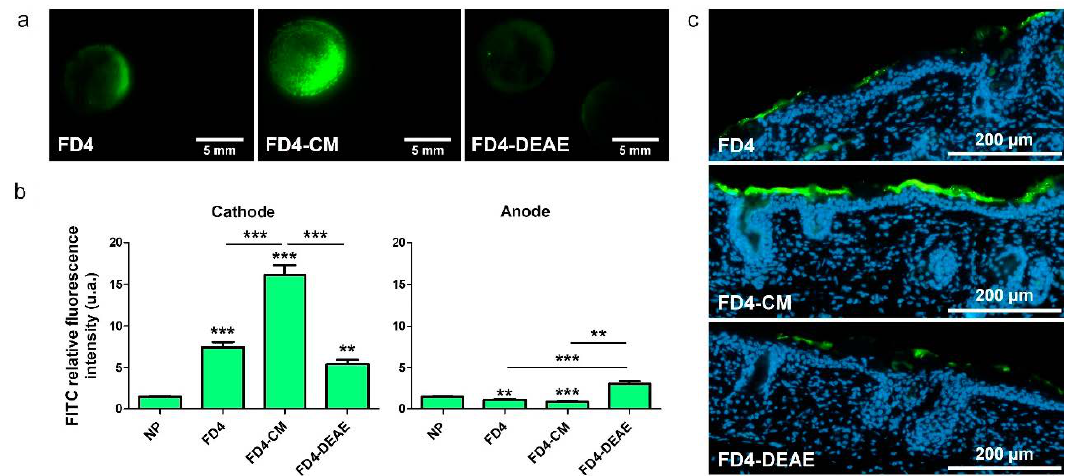
Figure 4. Influence of the molecule charge on delivery. Platforms loaded with either FD4, FD4 substituted with car- boxymethyl groups (FD4-CM), or diethylaminoethyl groups (FD4-DEAE) (1 mM) were used to apply unipolar EP treatment on hairless mice skin explants. Skins were imaged 30 min after. ( a ) Marking patterns on skin of FD4, FD4-CM and FD-DEAE loaded on the platforms after treatment with a unipolar-pulsed electric field. Cathode is always on the left. ( b ) Quantification of FITC RFI at the cathode and anode side of treated skins, compared to the matched RFI on non-pulsed skins (NP). Statistical analysis: one-way ANOVA, Turkey’s post-test comparison between NP, FD4, FD4-CM and FD4-DEAE. (Codes signification: ** = p > 0.01; *** = p > 0.001; else is non-significant). Error bars indicate SEM. n = 4–9. ( c ) Histological observations of 10 µ m slices of skin treated with EP using platforms loaded with either FD4, FD4-CM or FD4-DEAE. Only the cathodes are displayed. FITC is green and nuclei are labelled in blue by DAPI.